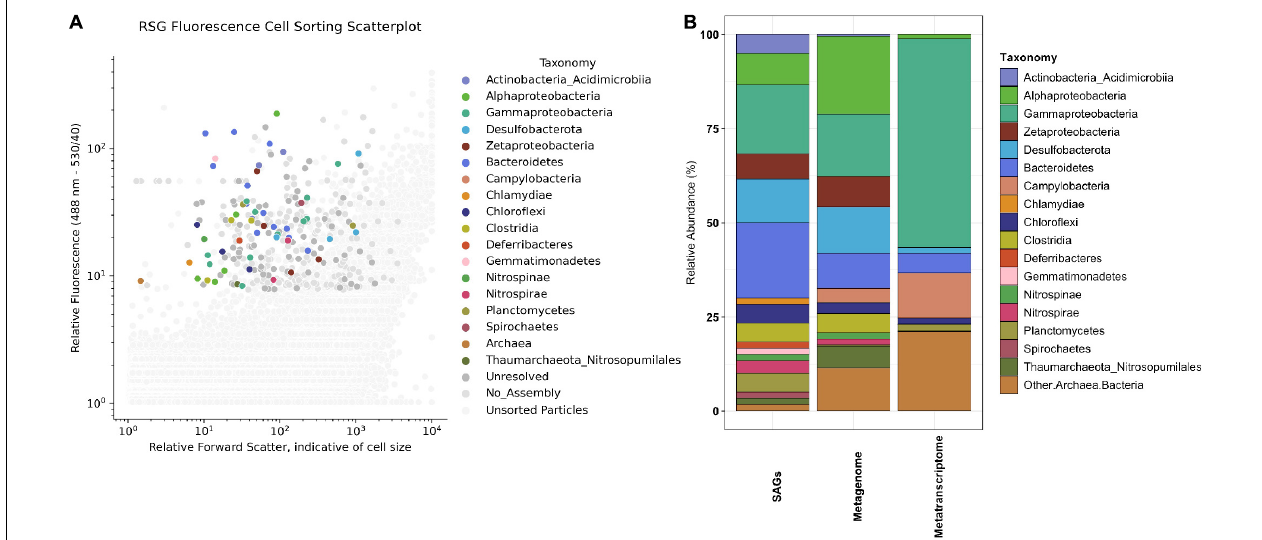
FIGURE 1 | (A) Taxonomic identity of active single cells (i.e., sorted based on RedoxSensor TM Green fluorescence) from subsurface crustal fluids from the deep horizon of IODP Hole U1383C collected in 2017 after indexed fluorescence activated cell sorting. The x-axis plots the particle/cell forward light scatter (FSC) after illumination with the 488 nm wavelength laser, indicative of cell size. The y-axis plots the relative fluorescence emission of particles (530 nm wavelength filter set with 40 nm bandpass). Color of symbol represents taxonomic identity of single cell amplified genome (SAG) according to legend, with dark gray symbols representing SAGs whose identity could not be resolved and lighter gray symbols indicating particles sorted that did not result in an assembled SAG. Small gray dots represent particles that were not index sorted for genome amplification. (B) Comparison of the relative abundance of taxa (at Phylum/Class level) in various sample types from North Pond Hole U1383C Deep fluids collected in 2017. The SAGs from this paper are the first column from the left, presented as the relative abundance of the 60 SAGs that received a taxonomic assignment via CheckM or BlastN of the 16S rRNA gene. The next two columns summarize the taxonomy from metatranscriptome and metagenome data from the 2017 U1383C Deep horizon described in Seyler et al.